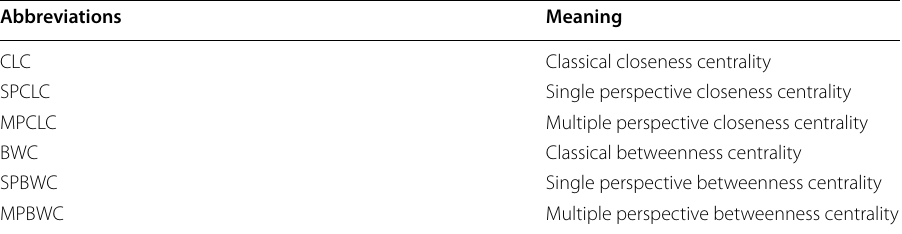
Table 1 List of